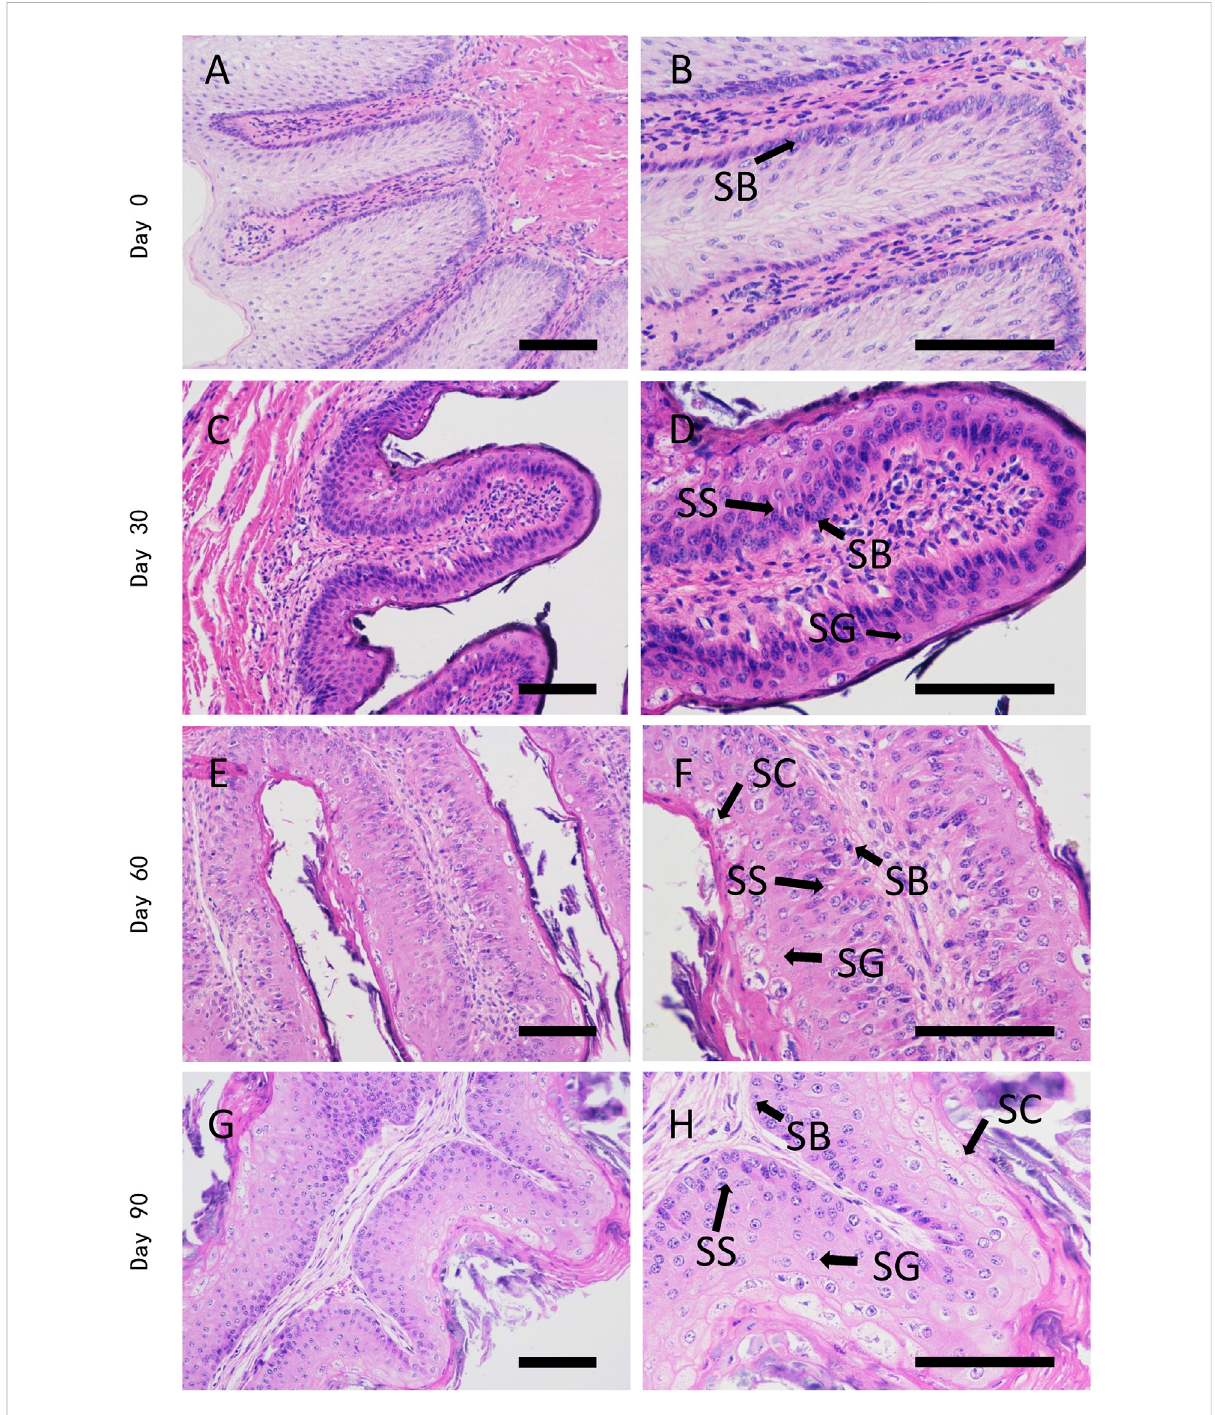
FIGURE 1 H&E staining of dairy cattle rumen epithelium on the age of day 0 (A , B) , day 30 (C , D) , day 60 (E , F) , and day 90 (G , H) . SB is stratum basale, SS is stratum spinosum, SG is stratum granulosum, SC is stratum corneum. Bar is 50 μ